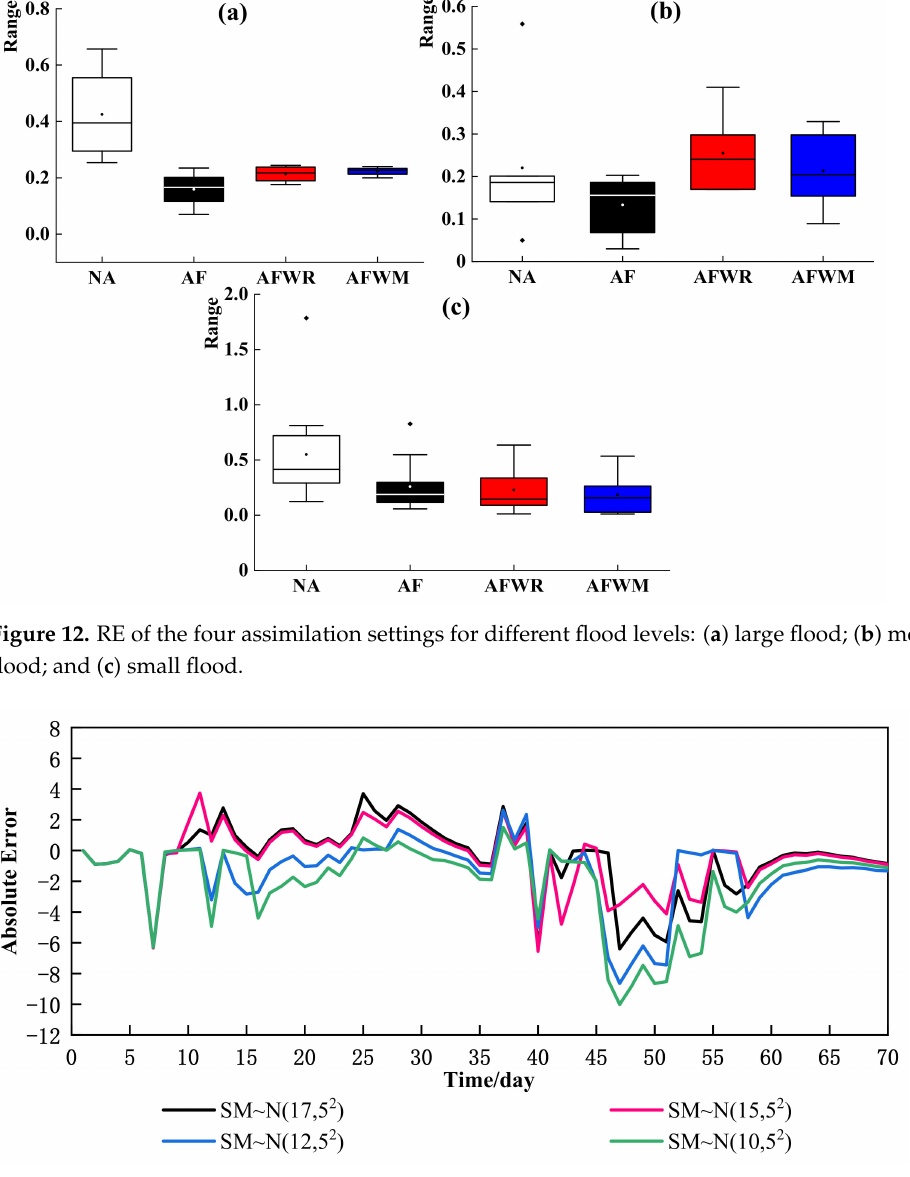
Figure 13. Absolute error variation of the assimilation with different mean